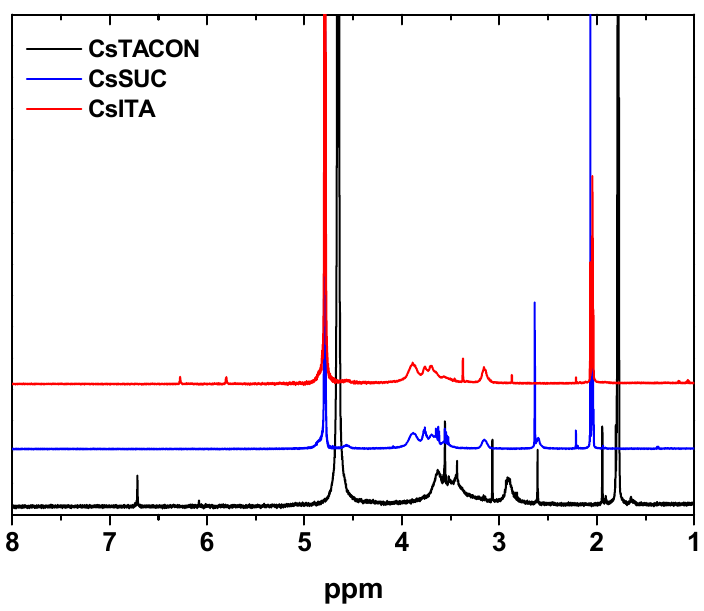
Figure 5. 1 H-NMR spectra of the synthesized chitosan derivatives.